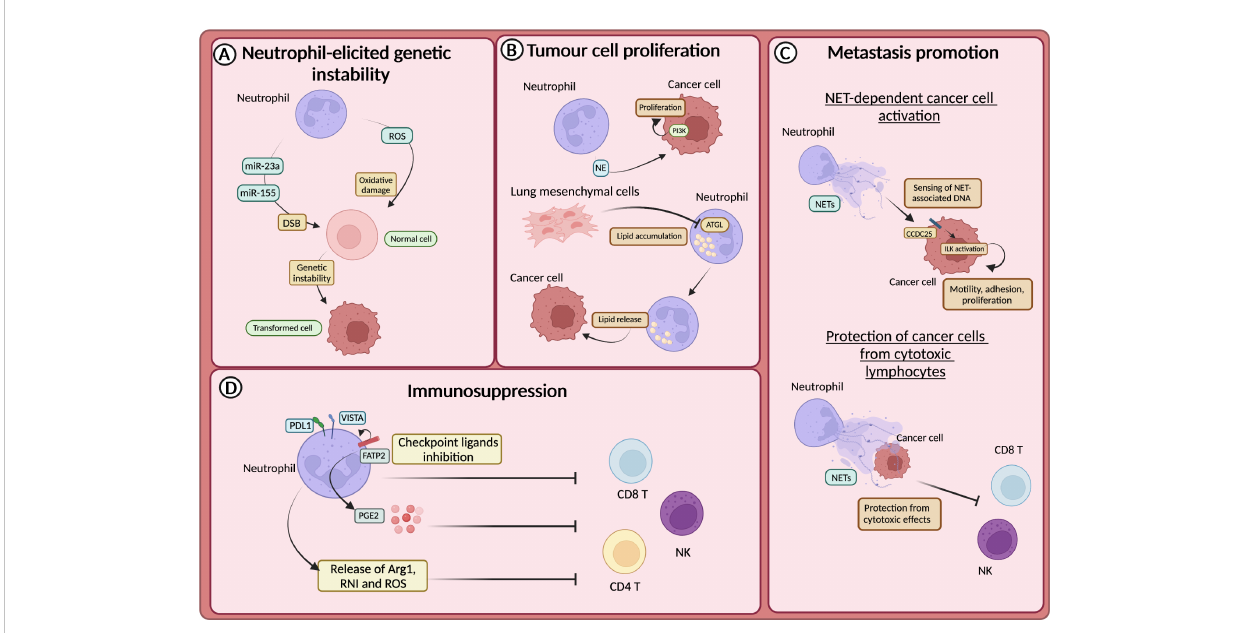
FIGURE 3 Neutrophils in tumour promotion (A) Neutrophil-derived reactive oxygen species (ROS) or miR23a and miR-155, by promoting the accumulation of double strand breaks (DSB), sustain genetic instability of cells. (B) Neutrophils sustain the proliferation of tumour cells through the release of neutrophils elastase (NE), and subsequent activation of PI3K. In the premetastatic niche, lung-resident mesenchymal cells forced neutrophils to accumulate lipids through the inhibition of the adipose triglyceride lipase (ATGL). Lipids are then released to feed tumour cells. (C) CCDC25 on tumour cells acts as a sensor for neutrophil extracellular trap (NET)-associated DNA and activates the integrin-linked kinase (ILK) signalling, promoting liver metastasis formation. NETs protect cancer cells from the cytotoxic activity of NK and CD8 + T cells. (D) Neutrophils drive immunosuppression and the dysfunction of T cells in various ways, including the expression of lymphocytes checkpoint (e.g., PD-L1 and VISTA), the production of ROS, arginase 1 (Arg1) or reactive nitrogen intermediate (RNI) and through fatty acid transporter protein 2 (FATP2)-dependent production of prostaglandin E2